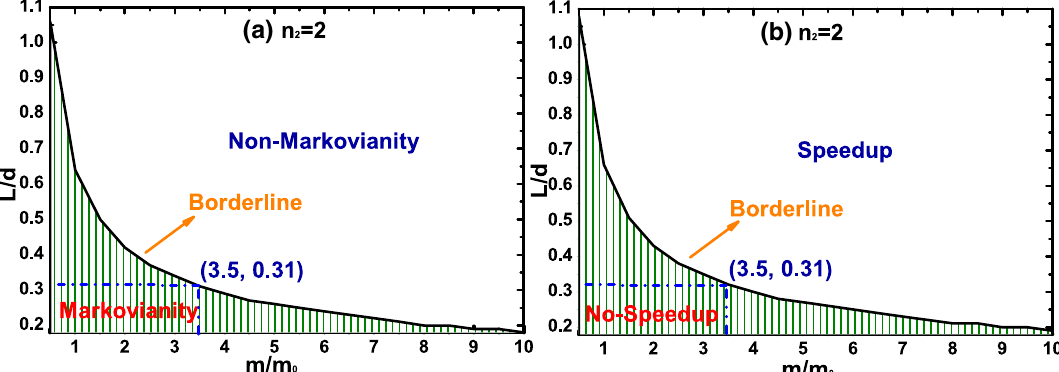
τ − m plane for the crossover between no-speedup dynam- QSL in the L ics and speedup dynamics. Here the actual evolution time τ = 0 . 4 s, d = 250 µ m and m 0 =10 − 13